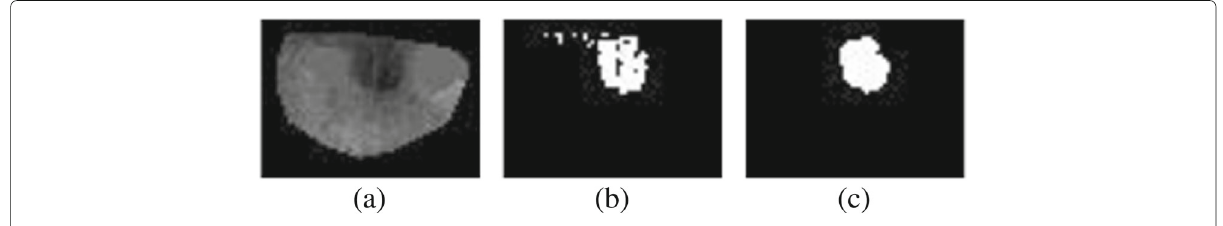
Fig. 7 Pupil segmentation. Dark structures enhancement ( a ), binarisation ( b ) and final pupil segmentation result ( c